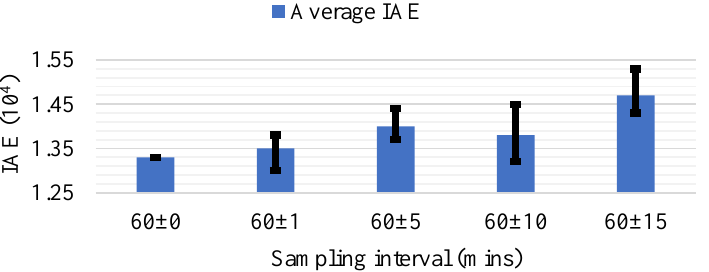
Figure 17. The effect of increased variation in the sampling time on the controller performance. The results taken as an average of five runs and error bars (black) were included to show the variation in the IAE in these runs.